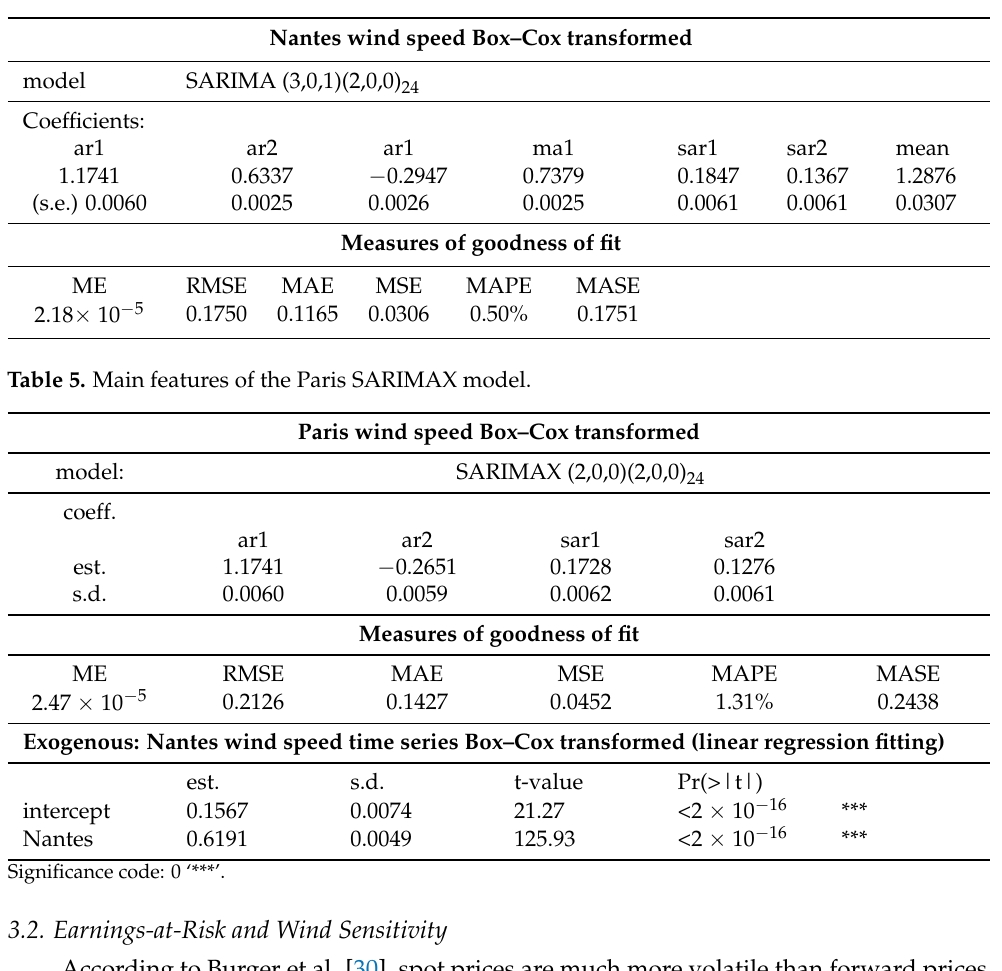
Table 4. Main features of the Nantes SARIMA model.